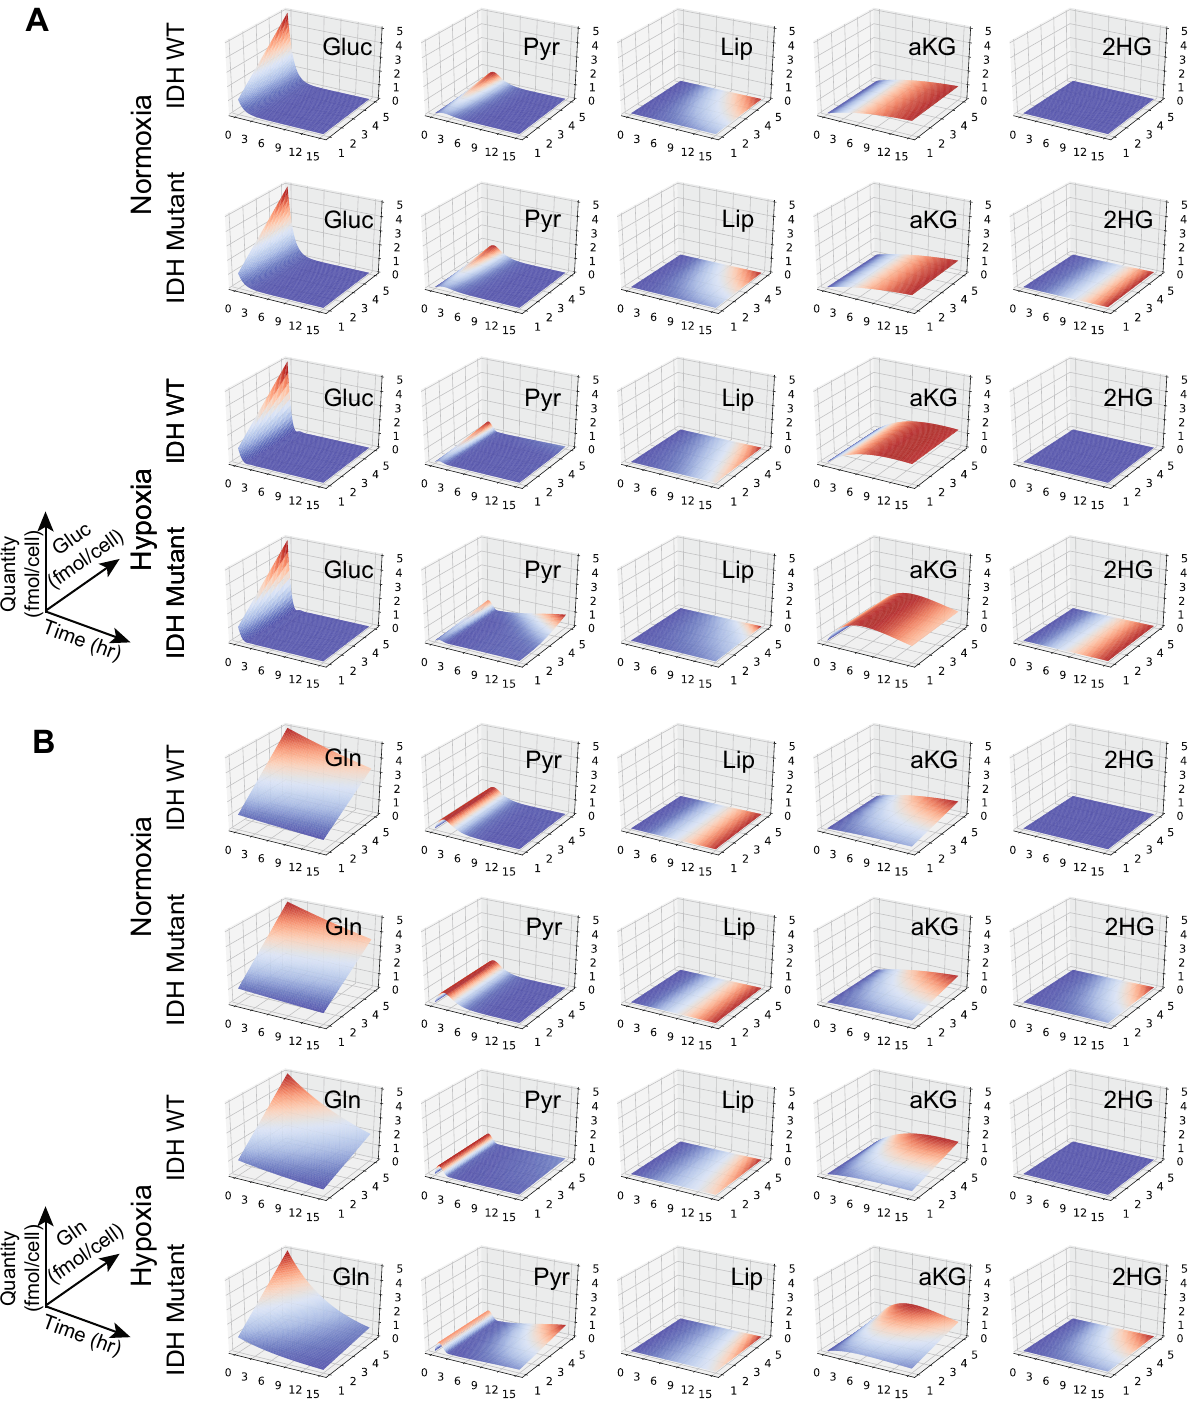
Figure 3. Effects of varying nutrient concentration on metabolites under normoxia and hypoxia conditions. ( A ) Effect of varying inital glucose concentration (from 1 to 5) with initial glutamine set to 5 (fmol/cell). ( B ) Effect of varying initial glutamine concentration (from 1 to 5) with initial glucose set to 5 (fmol/cell). The PRISM models were instantiated with corresponding phenotype and condition rates as in the experimental models. All other molecular species were initialized with 0. The model checking problem was expressed as characterizing the transient quantity of molecular species at a given instant in